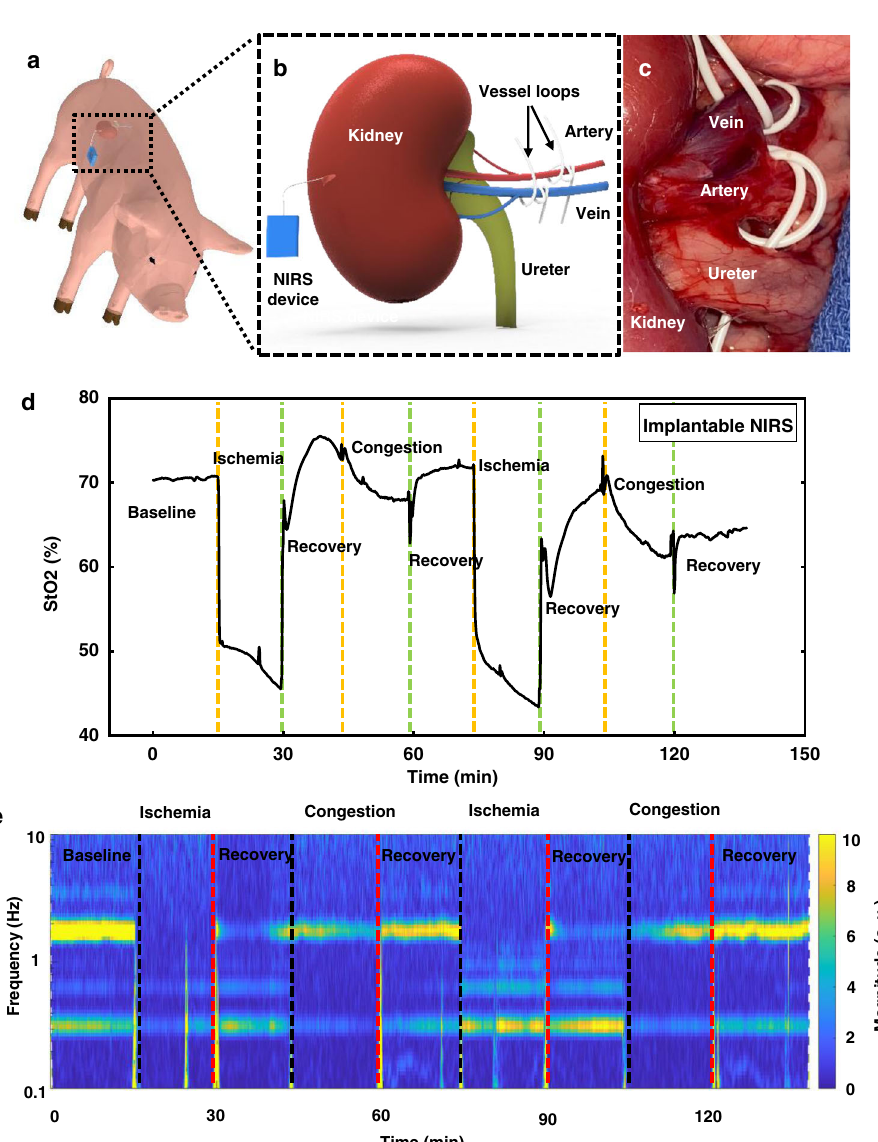
Fig. 5 In vivo measurements in a porcine kidney model. a , b Schematic illustrations of the implantation strategy of the NIRS probes in the porcine kidney model. c Image of the occlusion of arteries and veins to simulate events of ischemia and congestion, respectively, with vessel loops. d Measured tissue oxygenation saturation using the implantable NIRS probe through multiple experimental cycles of ischemia and congestion. The timeline of respective events (ischemia, congestion, and recovery) shows a consistent match with that of occlusion and release of arteries and veins. e Measured signals plotted as spectrograms to highlight variations of pulsation patterns and respiration patterns. The timelines match well with those of the occlusion and release events, respectively. Source data are provided as a Source Data fi